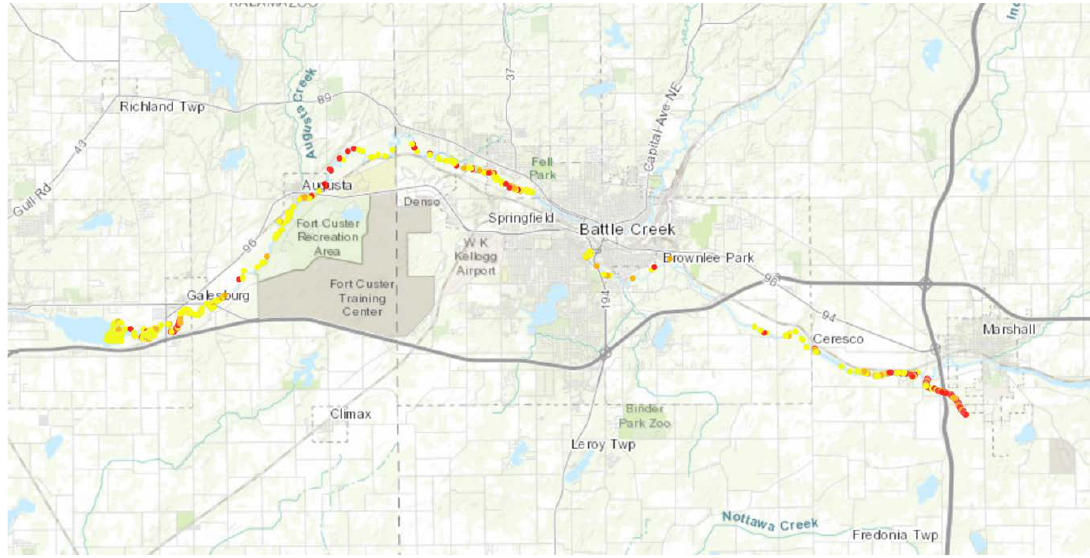
Figure 5. Poling data with sunken oil from 29 August–21 September 2010. Created using ArcGIS Pro. The yellow dots correspond to slight oiling, the orange to moderate oiling, and the red to heavy oiling. J. Mar. Sci. Eng. 2020 , 8 , x FOR PEER REVIEW